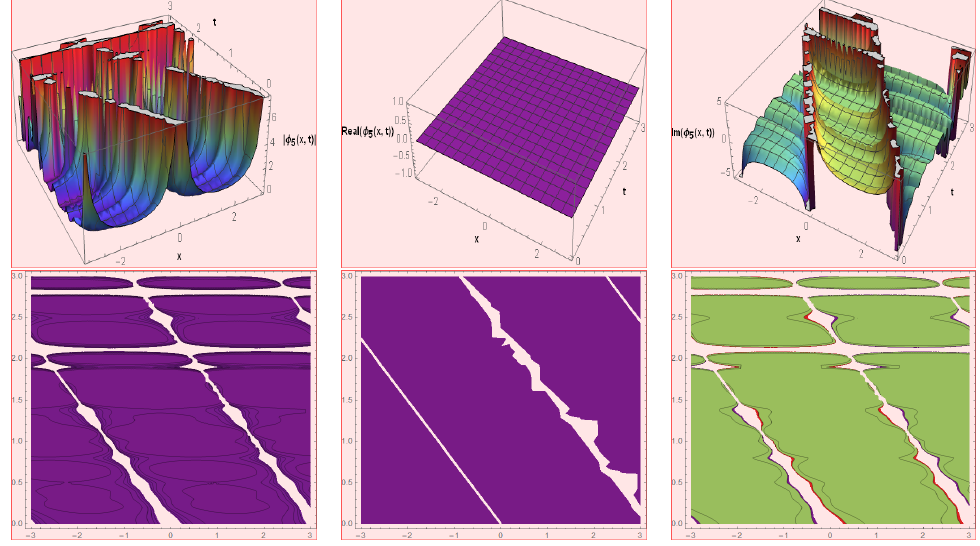
Figure 4. The absolute, real, and imaginary behavior in the shape of 3D and their corresponding contour plots are dispatched for φ 5 ( x , t )